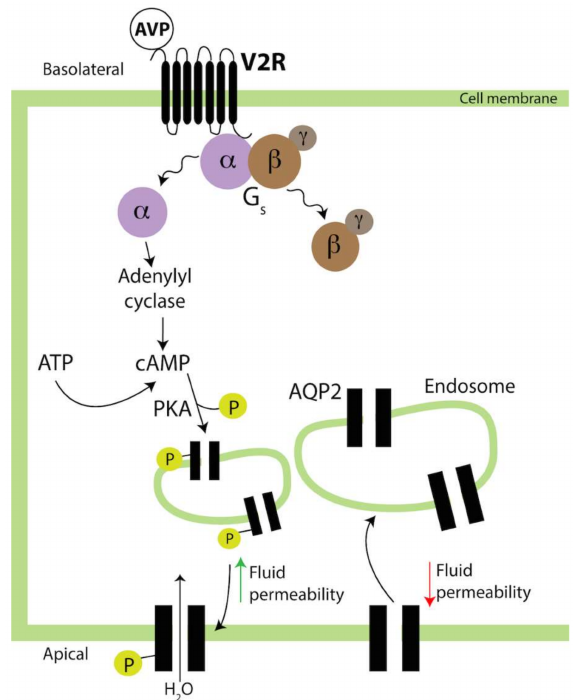
Figure 2. Intracellular response to AVP in renal tubular epithelial cells. AVP binds to the V2R G-protein coupled receptor on the basolateral membrane, which activates adenylyl-cyclase (AC). Produced cAMP activates protein kinase A (PKA), which phosphorylates the AQP2 water chan- nels stored in vesicular compartments. This promotes apical membrane relocation and increased transmembrane water transport (modified after